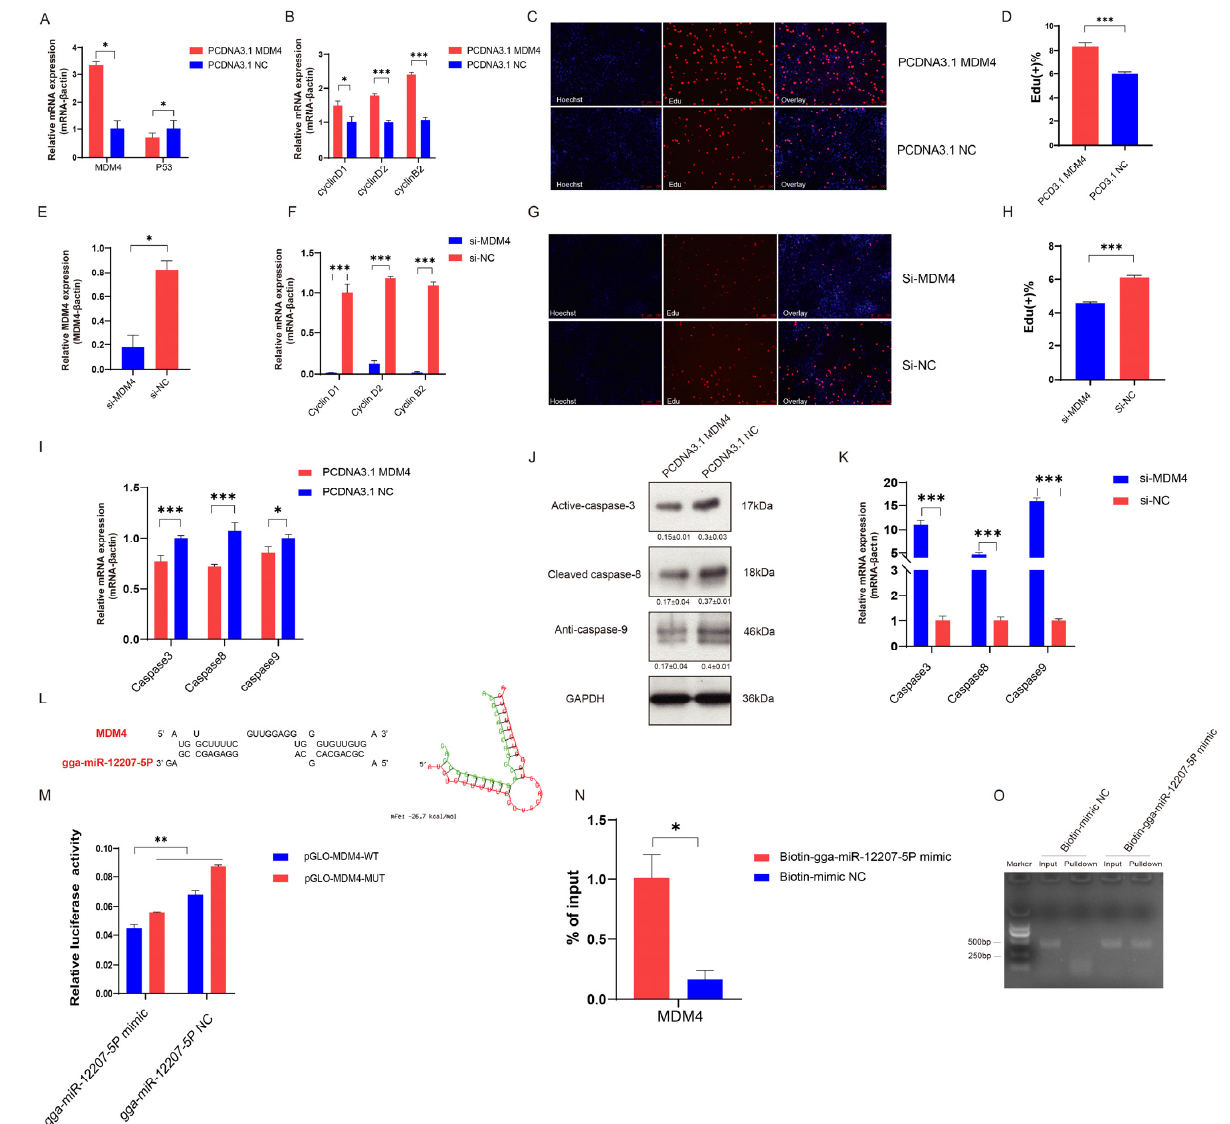
Figure 6. MDM4 promotes cell proliferation and inhibits apoptosis through the P53 signaling pathway. ( A ) MDM4 and p53 mRNA levels after transfection with MDM4 overexpression plasmid in CPMs. ( B ) qRT-PCR results of cyclin D1, cyclin D2, and cyclin B2 after MDM4 overexpression. ( C , D ) EdU staining ( C ) and the positive EdU cell rate ( D ) for myoblast cells after MDM4 overexpression. ( E ) MDM4 mRNA levels after transfection with MDM4 silencing vector in CPMs. ( F ) qRT-PCR results of cyclin D1, cyclin D2, and cyclin B2 after MDM4 silencing. ( G , H ) EdU staining ( G ) and the positive EdU cell rate (H) for myoblast cells after MDM4 knockdown. ( I , J ) Relative mRNA level ( I ) and protein level ( J ) of caspase 3, caspase 8, and caspase 9 expression after MDM4 overexpression. ( K ) Relative mRNA level expression of caspase 3, caspase 8, and caspase 9 genes after MDM4 gene silence. ( L ) Potential binding sites between MDM4 and gga-miR-12207-5P predicted by RNAhybrid online tool. ( M ) Relative luciferase activity of pmirGLO- MDM4 WT/MUT plasmid with gga-miR-12207-5P mimic or gga-miR-12207-5P NC. ( N , O ) mRNA level ( N ) and RNA level ( O ) of the biotin-tagged miRNA pulldown assay (* p < 0.05; ** p < 0.01, *** p < 0.001). EdU staining assays also suggested that MDM4 overexpression induced CPM prolif- eration (Figure 6B–D). On the contrary, silencing the MDM4 gene repressed the relative mRNA expression of cyclin D1 , cyclin D2 , and cyclin D3 , as well as the total number